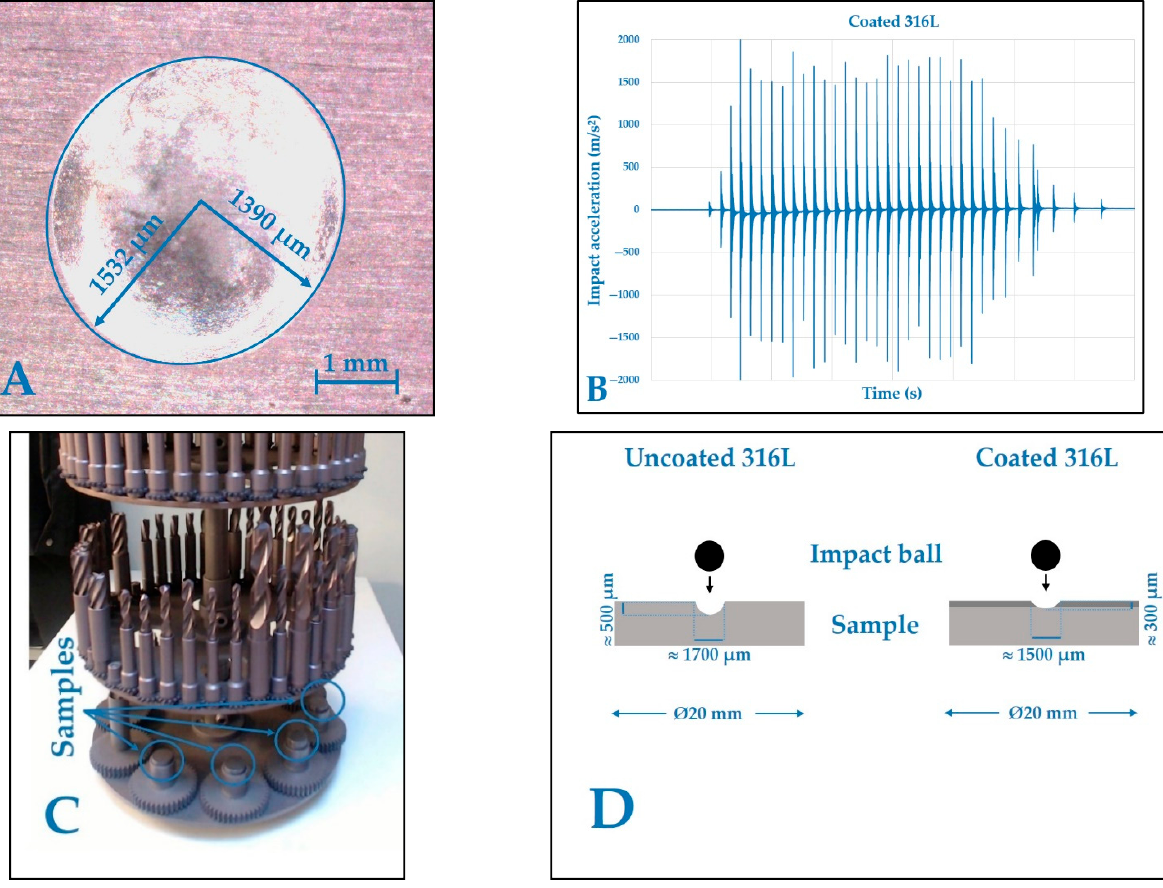
Figure 8. ( A ) Optical micrograph of indent and ( B ) acceleration measurement of impacts for coated 316L, ( C ) arrangement of samples in the PVD device, and ( D ) schematic illustration of the effect of 316L with PVD coating.